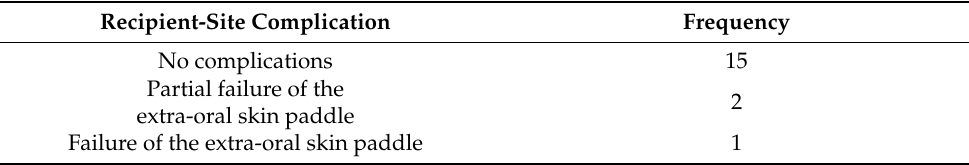
Table 3. Frequency of recipient-site complications ( n =